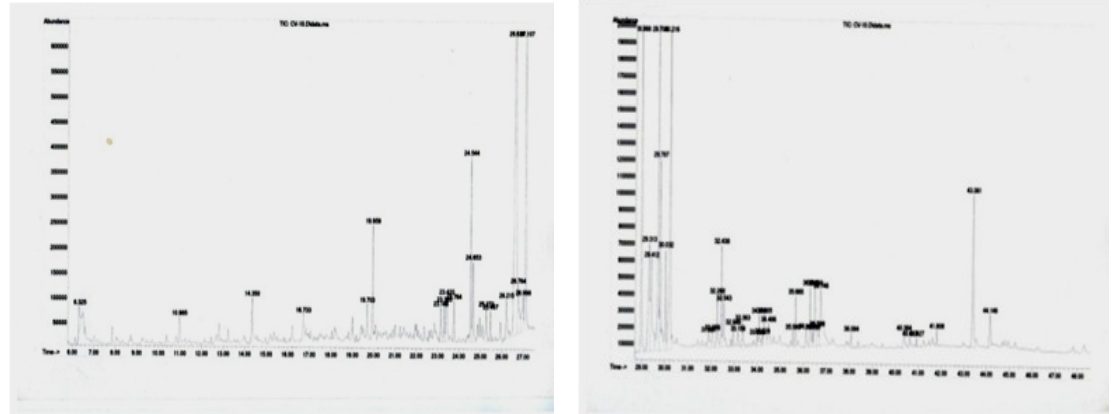
Fig. 1. GC-MS Chromatograms of the chloroform fraction of the roots (July) of Cicuta virosa L. The GC-MS chromatograms of the chloroform fraction of the roots (July) of Cicuta virosa L are shown in figure 1. The GC-MS spectral studies revealed the presence of 49 volatile compounds. Amongst them